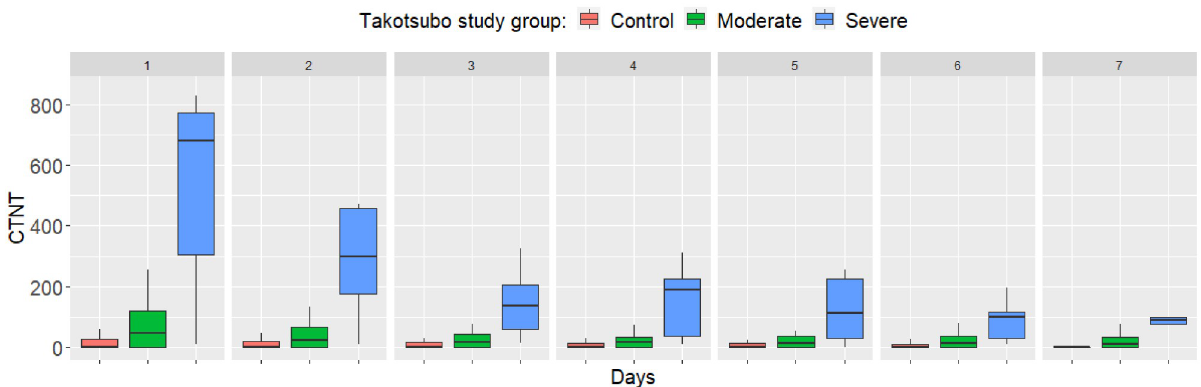
Fig 2. Differences in cardiac troponin T (CTNT) between study groups from day 1 to 7. Boxplots show the median, upper and lower quartiles, and minimum and maximum values, with outliers omitted for clarity. Differences are highly significant each day (p < 0.001).